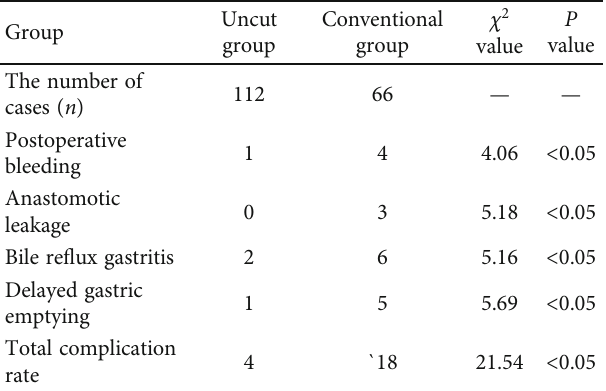
Table 2: Two groups of patients with complications.